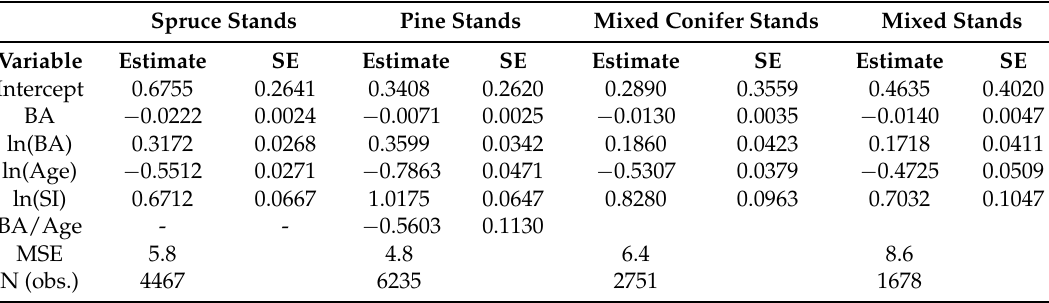
Table A2b. Coefficients for the net basal area growth (BA i , 5 years)